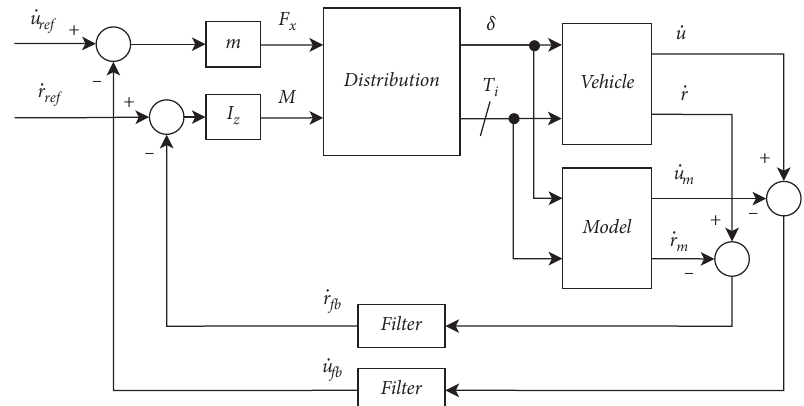
Figure 4: Optimization-based inner loop with